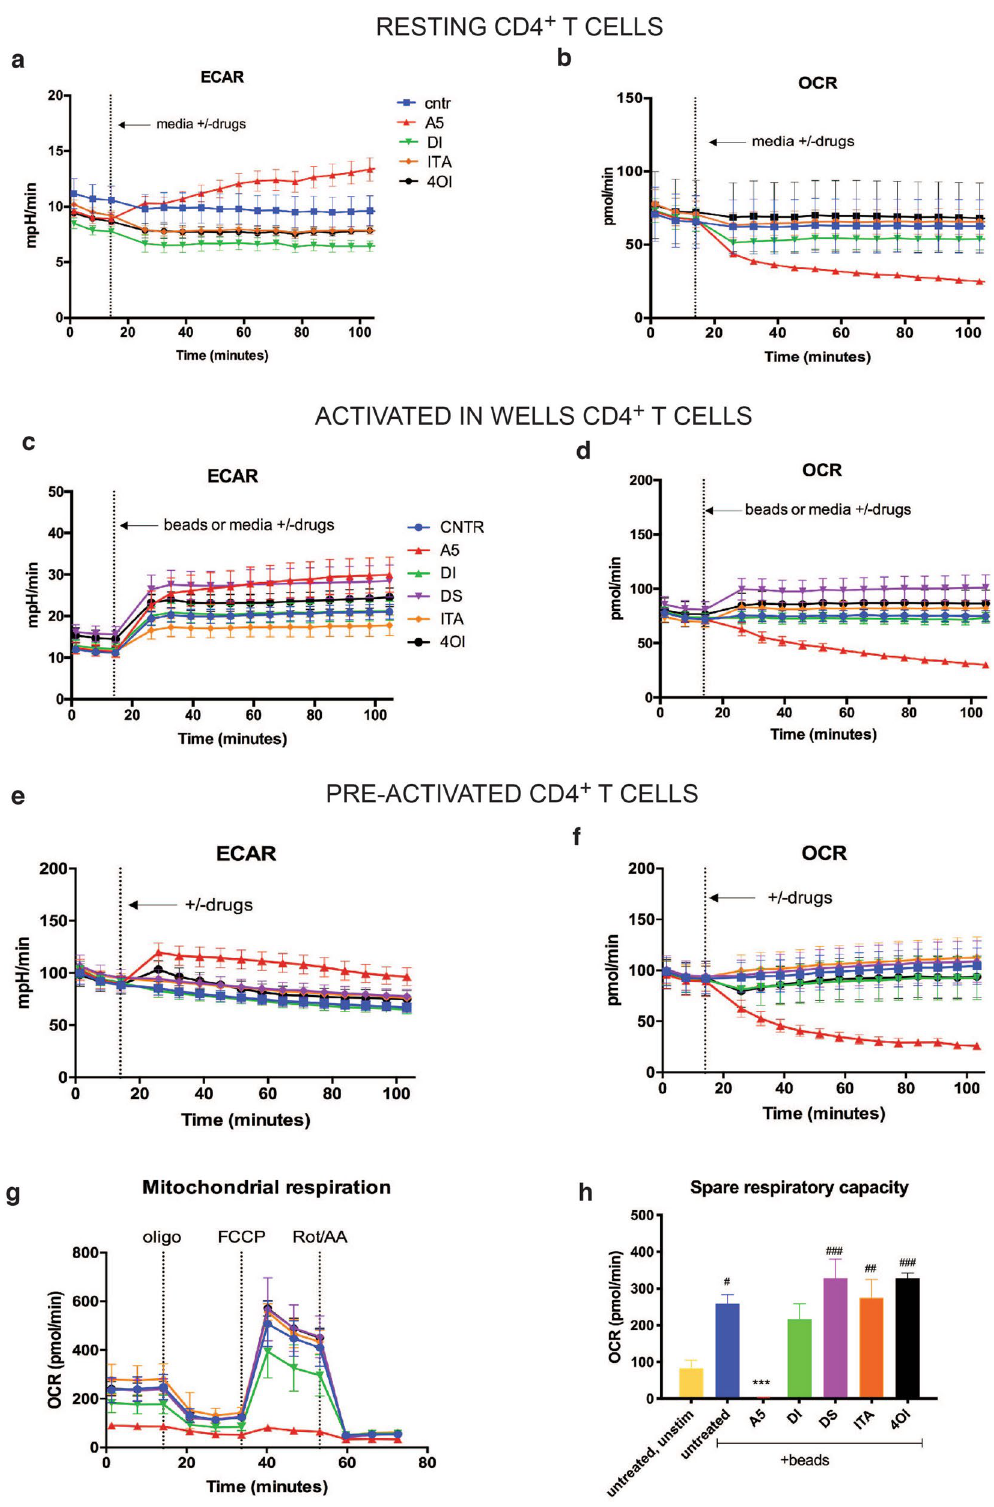
Figure 6. Mitochondrial respiration is pivotal for a proper T cell activation. Seahorse analysis of ECAR and OCR in ( a , b ) resting, ( c , d ) activated in wells, ( e – h ) and pre-activated CD4 + T cells. ( g , h ) Mitochondrial stress assay performed with oligomycin, FCCP, and rotenone/antimycin A on pre-activated and pre-treated CD4 + T cells. ( a – f ) n = 9 independent experiments, ( g , h ) n = 3 independent experiments, all with n = 3 technical replicates. Charts show mean and ± s.d, ( a – g ) or s.e.m. ( h ). As previously, we treated the cells with: A5 (20 μM), DI (250 μM), DS (1 mM), ITA (1 mM), 4OI (125 μM). P values are calculated using one-way ANOVA test followed by Dunnet’s test to different control groups: (#) to the unstimulated and untreated control, and additionally (*) to the activated untreated control. # or *P < 0.05, ## or **P < 0.01, ### or ***P < 0.001, #### or ****P <